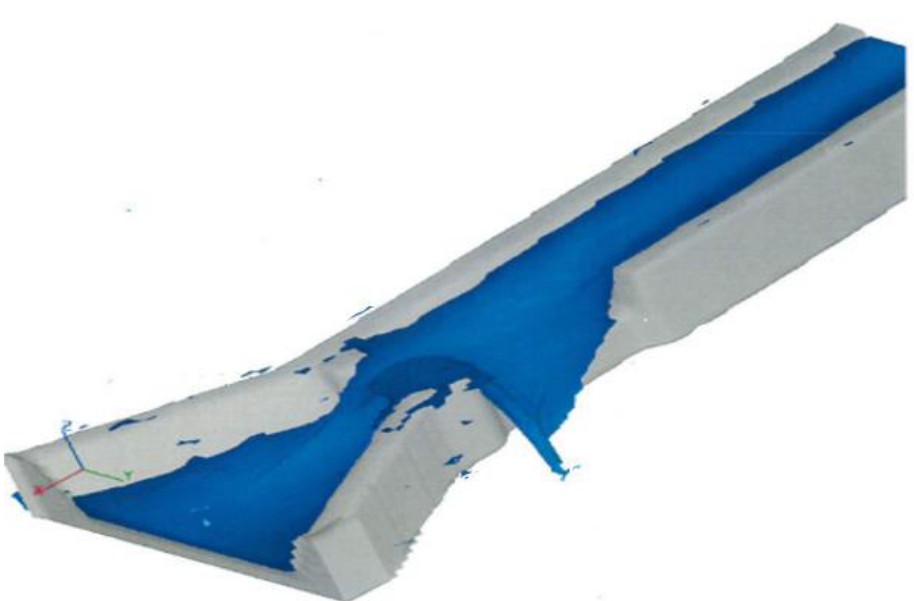
Figure 12. FLOW-3D CFD computed exit flow subtraction from the Figure 10, D location at the design flow rate. Figure from [1], p. 120.